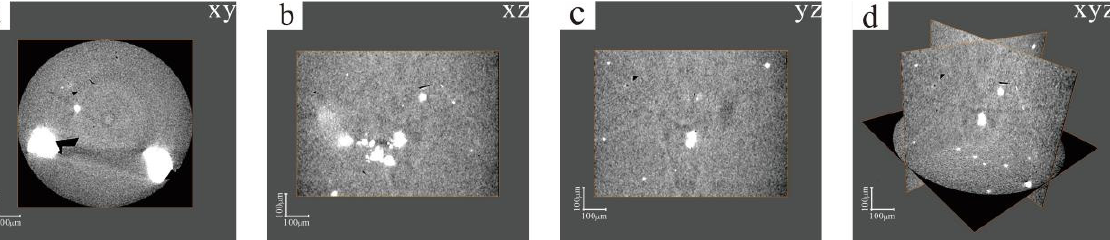
Figure 12. Micro-CT slice image of sample HZ-9 in the Huize lead–zinc deposit.( a ) Sample xy section Micro-CT scan image; ( b ) Sample xz section Micro-CT scan image; ( c ) Sample yz section Micro-CT scan image; ( d ) Micro-CT scanning mosaic image of sample xyz section